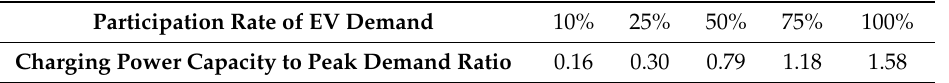
Table 8. Charging power capacity to peak demand ratio by various EV participation rates in 2030.